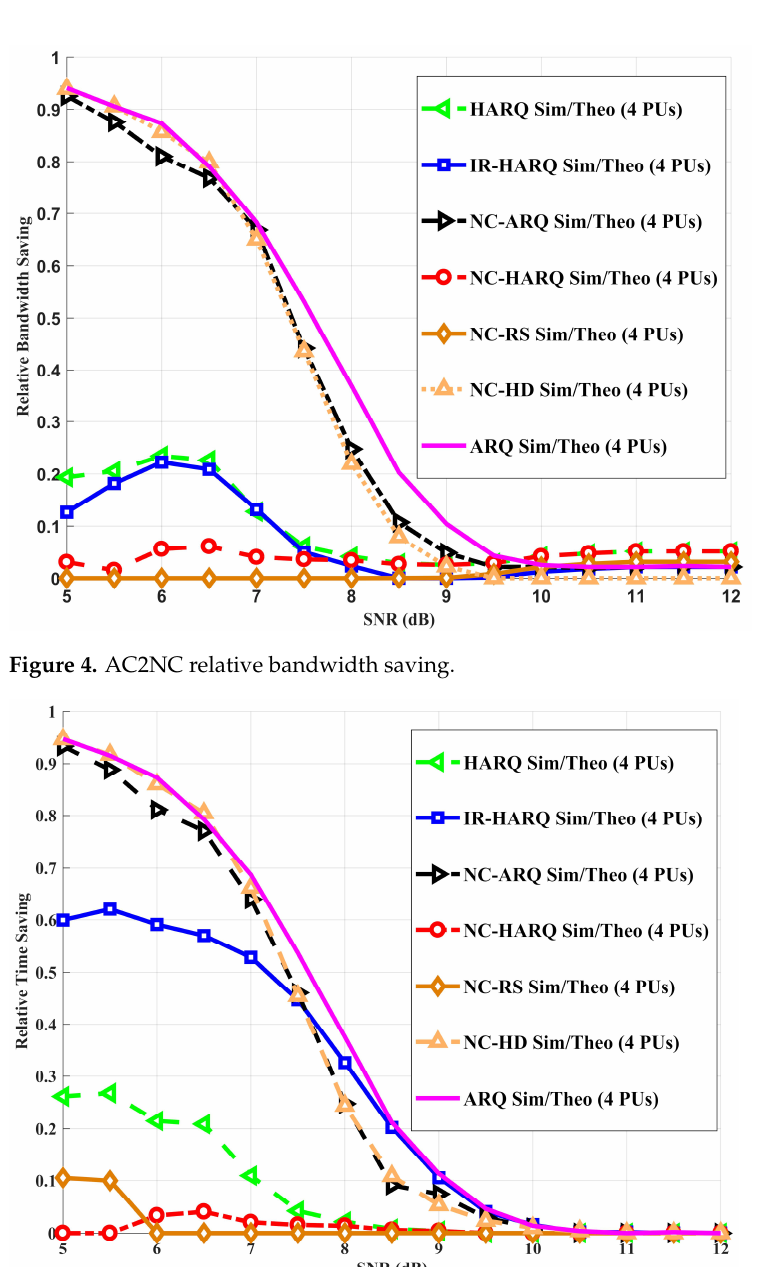
Figure 5. AC2NC relative time saving.